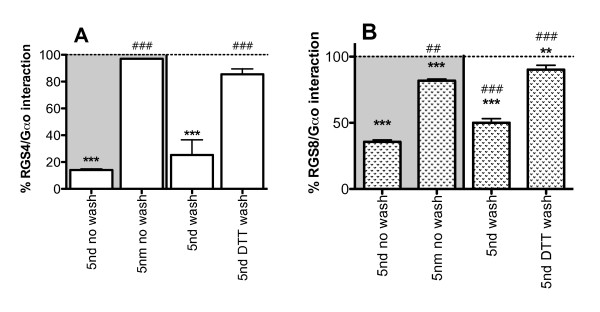
Irreversibility experiments. RGS-biotin on avidin beads was treated with 5nd (100 μM) or 5nm (100 μM) and then washed in buffer (with or without 1 mM DTT) or not washed and put in the FCPIA using RGS4 (A) or RGS8 (B) (mean ± S.E.M., n ≥ 2) *p < 0.05, **p < 0.01, ***p < 0.001 compared to no peptide (100%); #p < 0.05, ##p < 0.01, ###p < 0.001 compared to 5nd no wash.